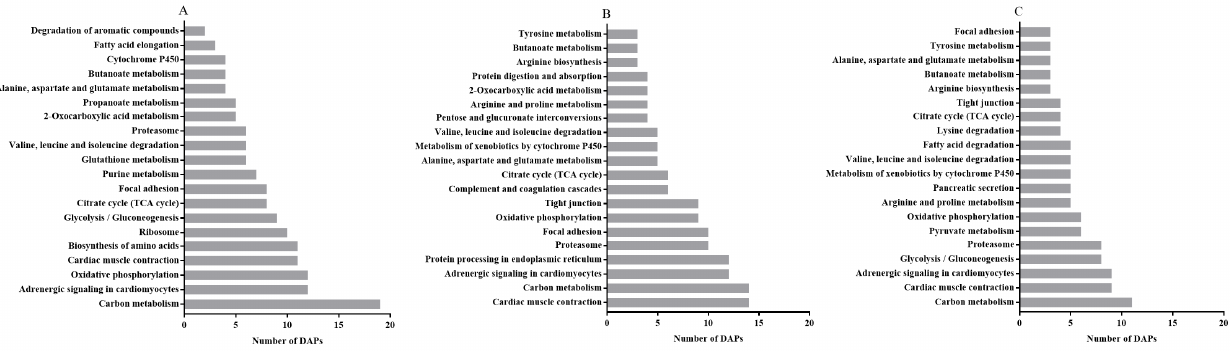
Figure 5. The 20 most enriched pathways of DAPs by Kyoto Encyclopedia of Genes and Genomes (KEGG) analysis between the CON and LP groups on days 0 ( A ), 5 ( B ) and 7 ( C ), arranged according to the number of DAPs. DAPs: differentially abundant proteins.